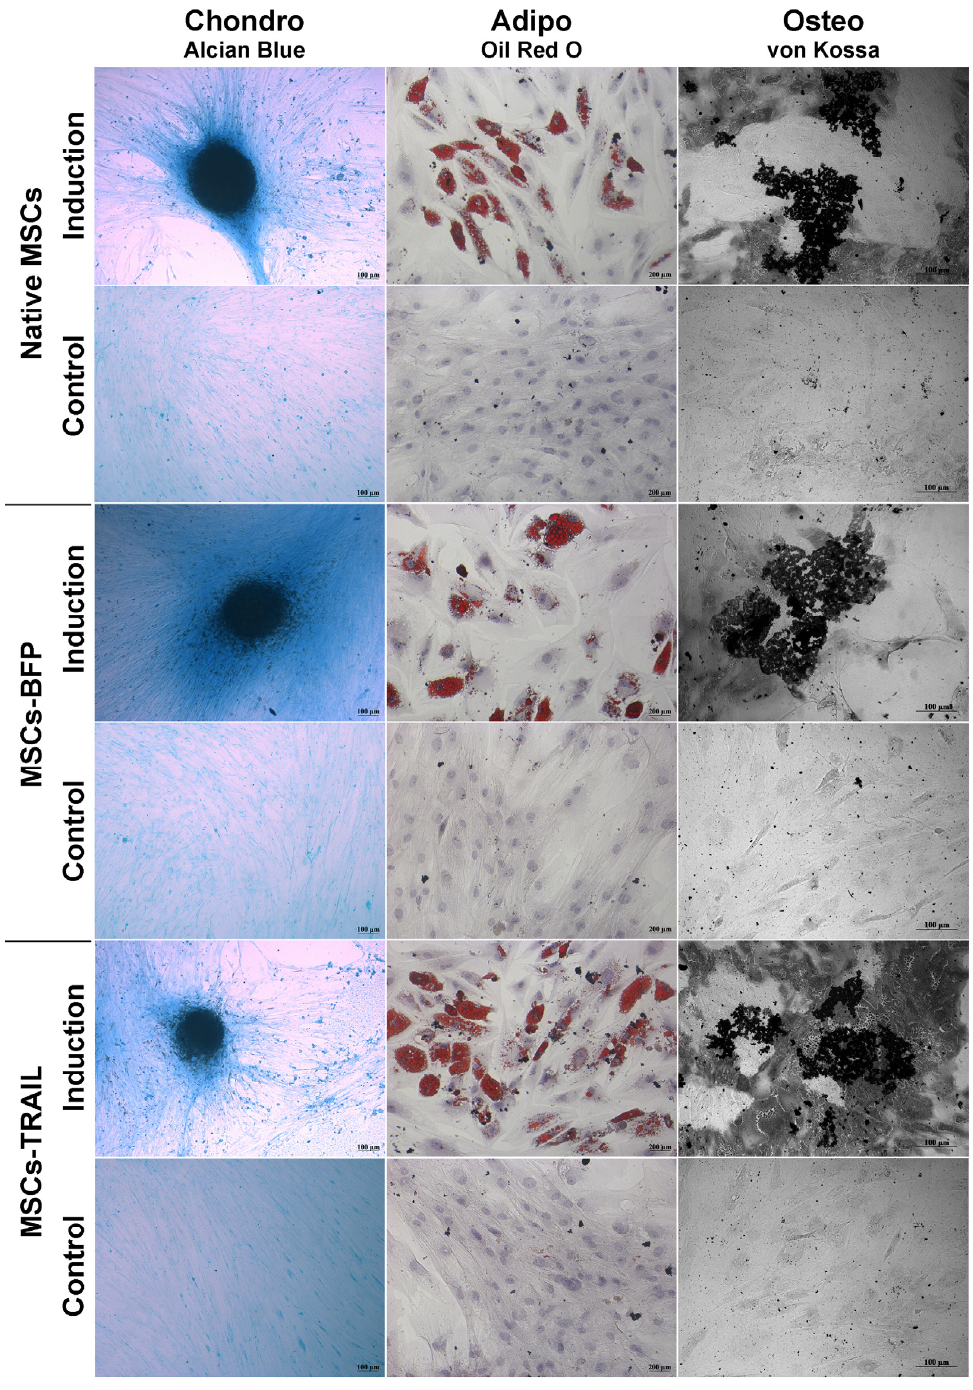
Figure 2. Osteogenic, adipogenic and chondrogenic differentiation of hADSCs. Phase contrast microscope images. To differentiate toward adipogenic lineage, native and TRAIL-genetically modified cells were cultured in reprogramming medium for 14 days. At day 14, cells were fixed and stained with Oil Red O. For osteogenic differentiation, the cells were cultured in reprogramming medium for 28 days. At day 28, cells were fixed and analyzed by von Kossa staining. Chondrogenic differentiation was determined by staining with Alcian blue on day 21 after seeding (adipogenic: scale bar, 200 µm; chondrogenic and osteogenic differentiation: scale bar, 100 µm).